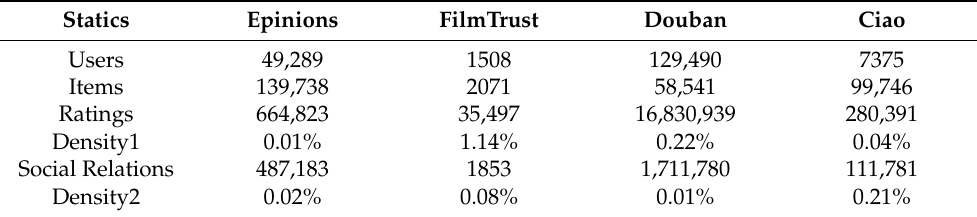
Table 2. Statistics of